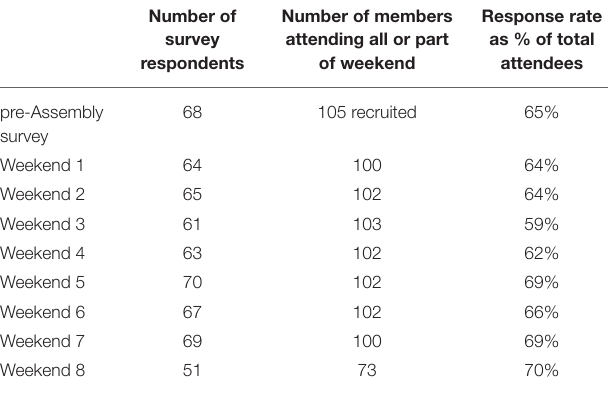
TABLE 1 | Assembly member survey response